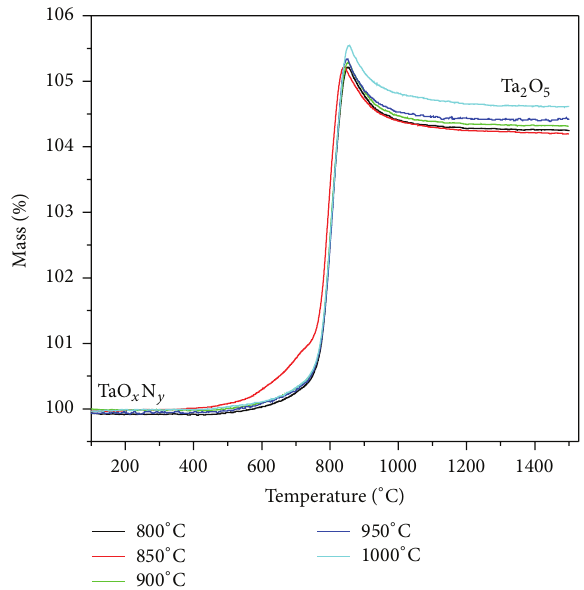
Figure 4: Thermogravimetric analysis (TGA) of the synthesized 𝛽 - TaON powders.